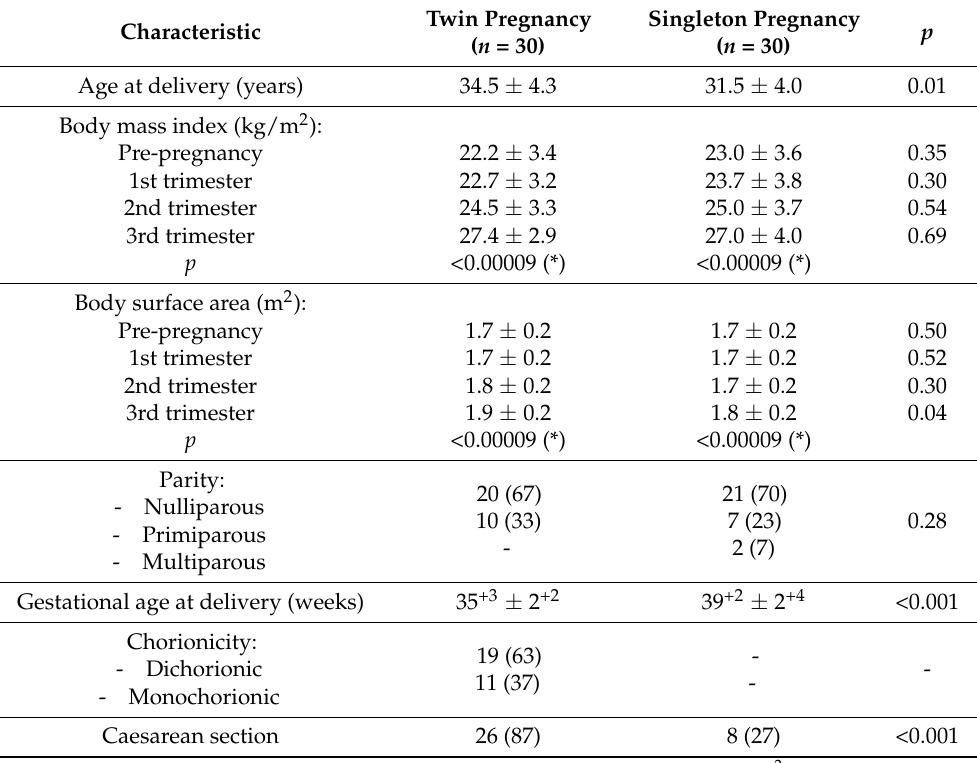
Table 1. Demographical characteristics of the enrolled cohort.